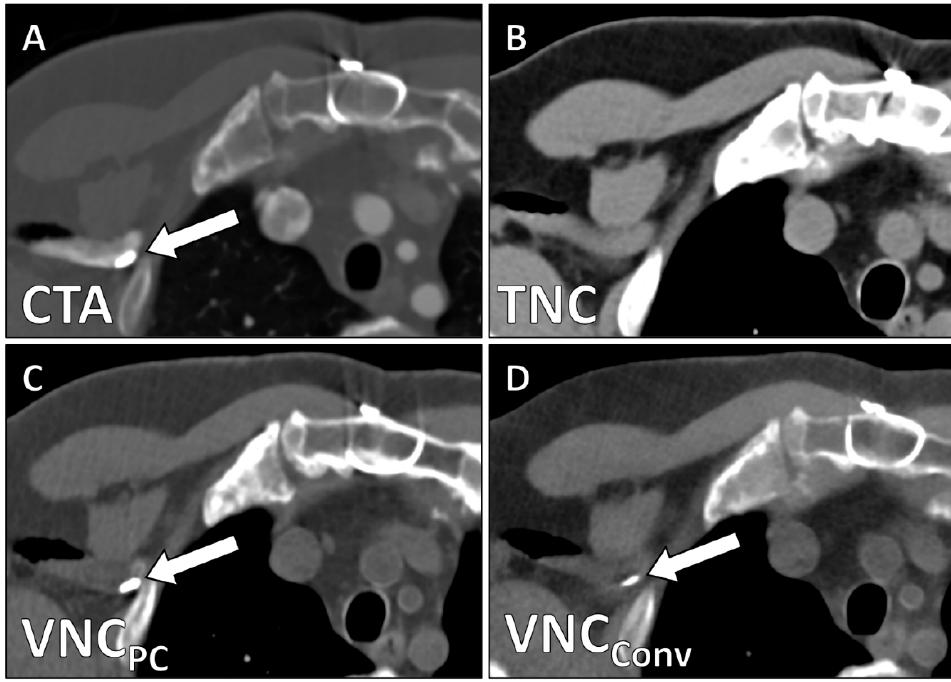
Figure 4. High-density contrast accumulation in the right subclavian vein (white arrow) is visible in the arterial phase scan ( A ) but not in the TNC-series ( B ). Residual non-subtracted contrast in both VNC PC - ( C ) and VNC Conv -series ( D ).